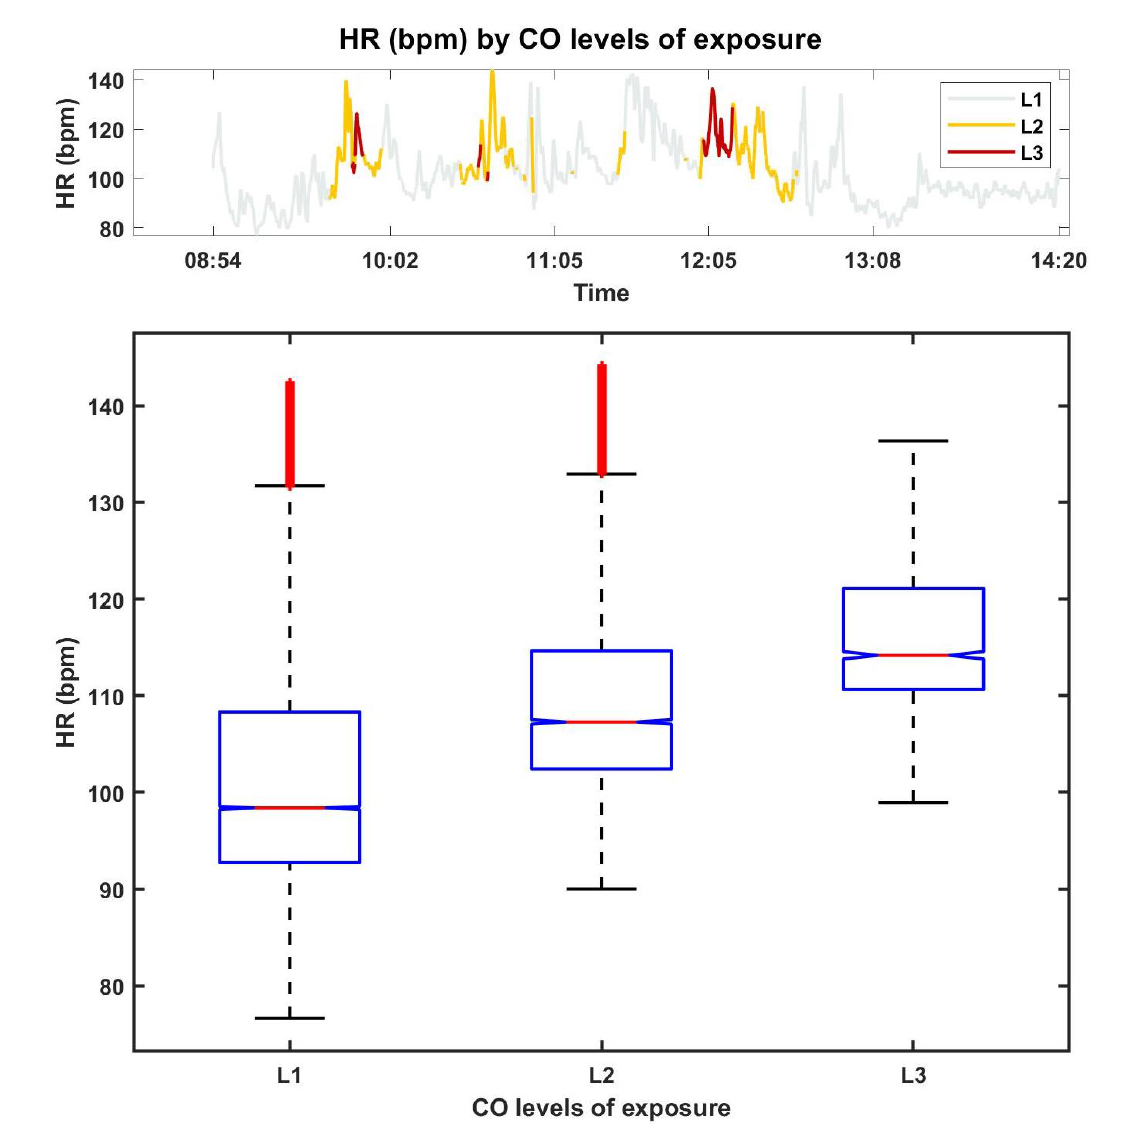
Figure 5. Box plots of the HR of FF7, per exposure